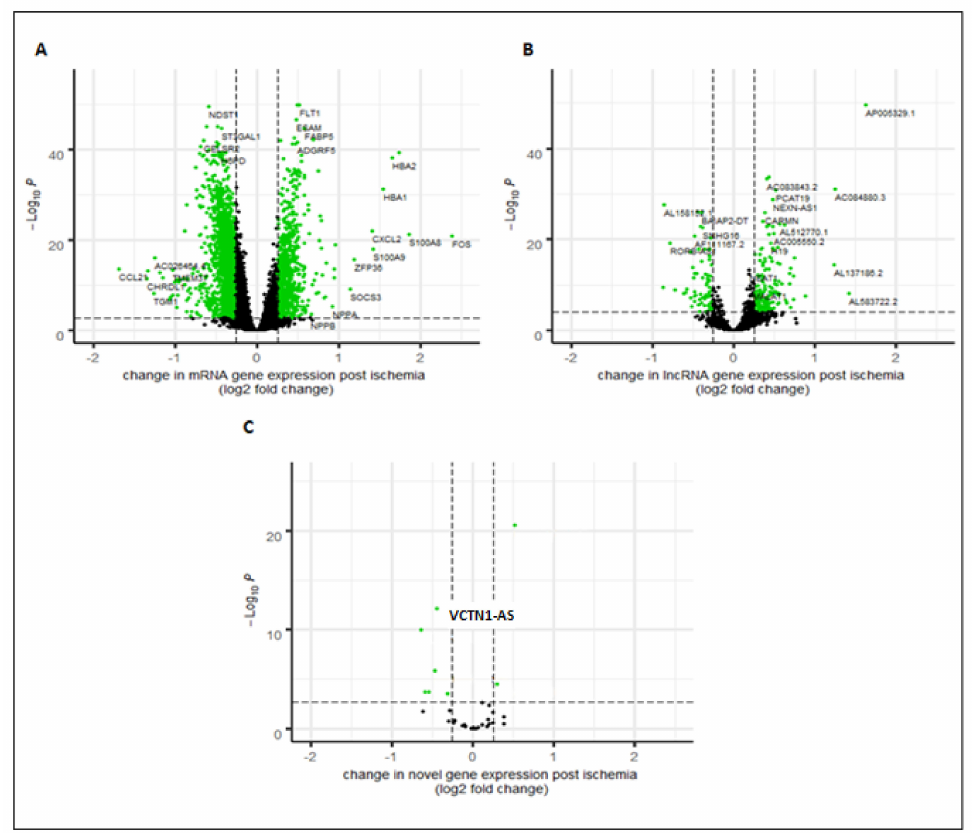
Figure 1. Volcano plots showing differential expression in 81 paired human left ventricle samples, comparing pre- versus post-ischemia: ( A ). mRNA genes, ( B ). annotated long noncoding RNA (lncRNA) genes, and ( C ). putative novel lncRNA transcripts. Green indicates differentially expressed genes/transcripts adjusted p value (padj) < 0.001 with an absolute fold change